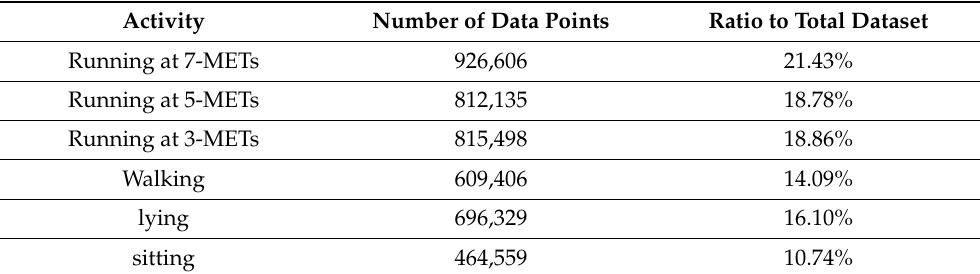
Table 3. Number and ratio of samples for each type of activity class.